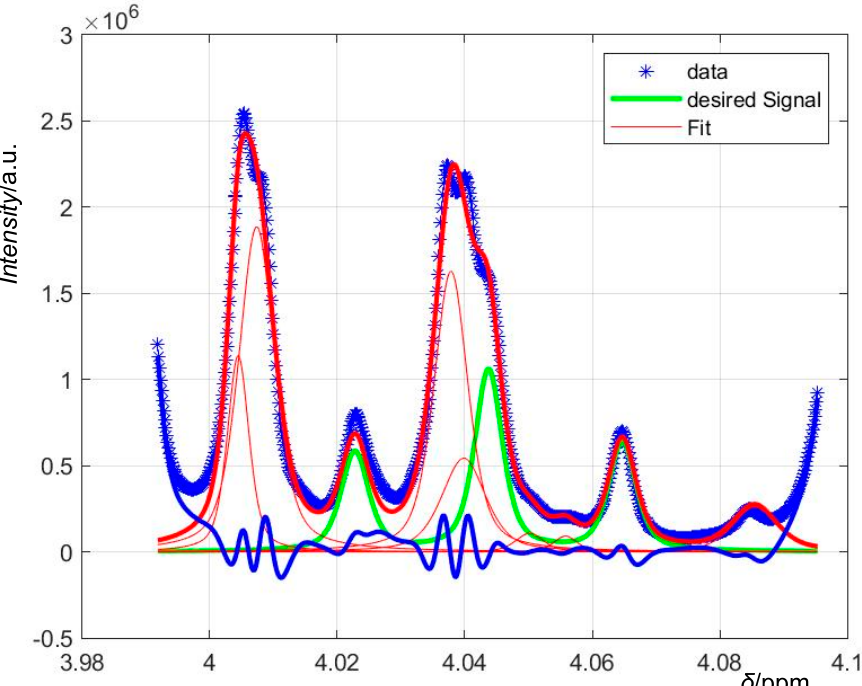
Figure 2. Curve fit of the sucrose triplet (thick green line). Although the resonance is not at all separated from the fructose double-doublet (compare Figure 1), the algorithm can again separate the desired signal from interfering signals (approximated as simple singlets, the thin red lines) arriving at a good representation of the original data (blue asterisks) with acceptably low residues (thick blue line).